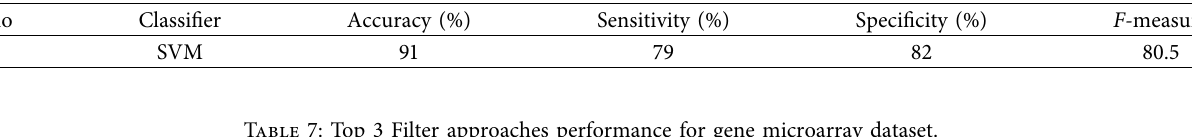
Table 6: SVM performance on most relevant features using intersection.